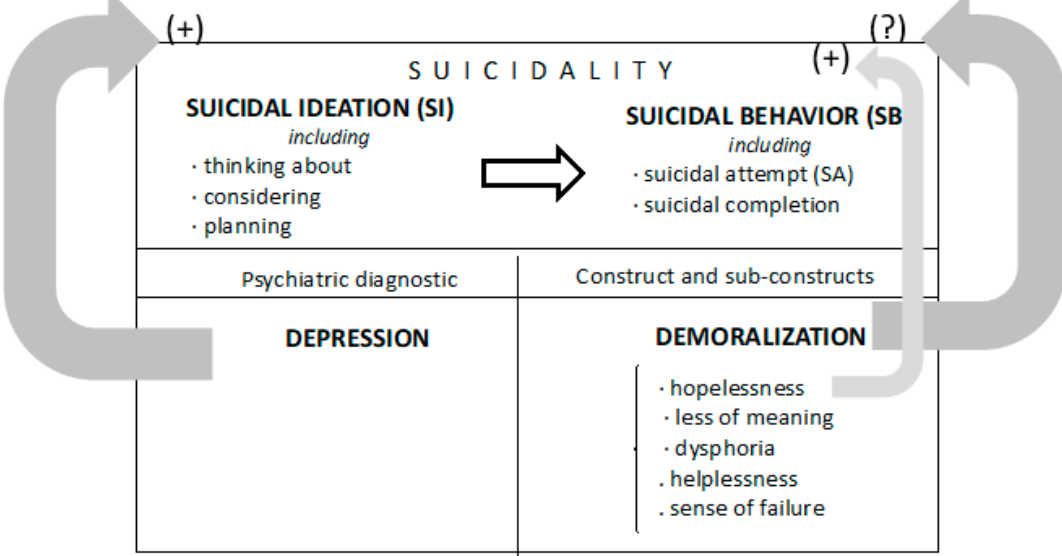
Figure 1. Schematic of the study design to determine the role of demoralization in suicidal patients attending an emergency department (ED). Depression is known to directly influence suicidality (SI + SB). However, less is known about the role of the demoralization construct. The aims of the present study were to: (i) assess the presence and severity of demoralization in suicidal patients visiting an ED; (ii) determine whether the demoralization construct can be parsed independently from depression as a factor associated to suicidality; and (iii) investigate whether the proportion of variance in the relationship between suicidality and demoralization is accounted for by the sub-construct